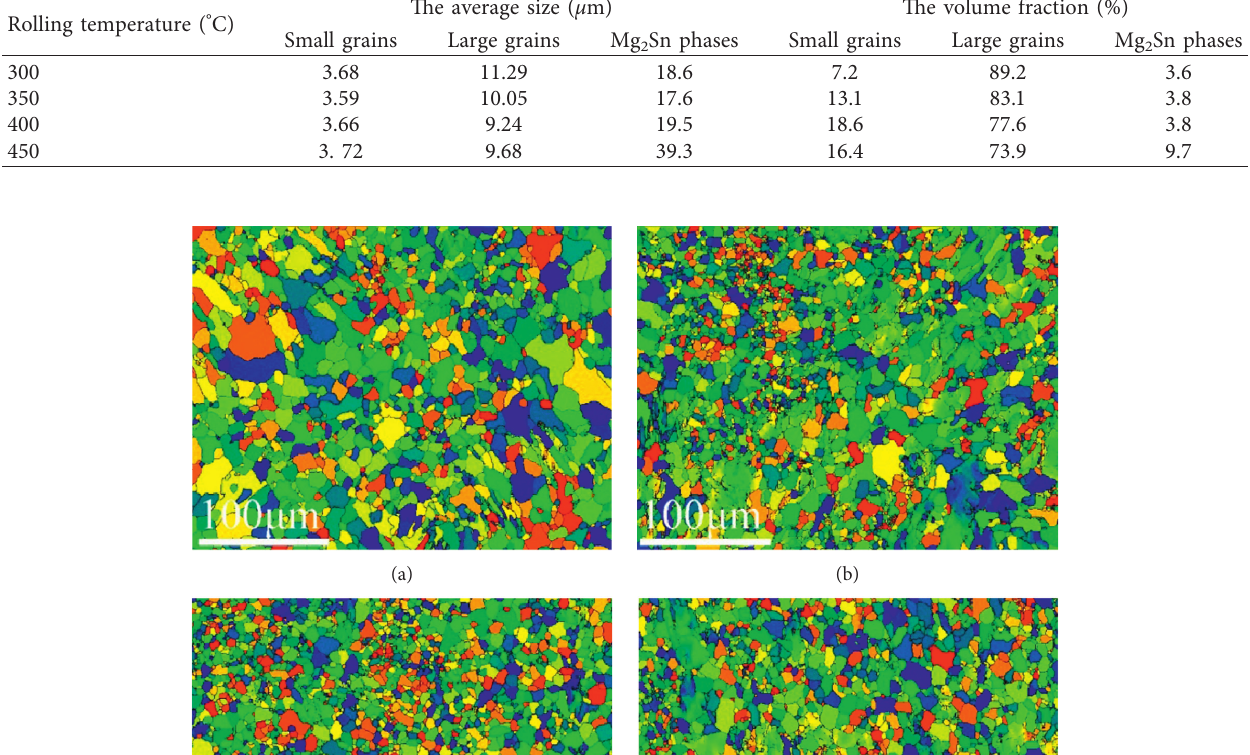
Table 1: The average sizes and volume fractions of Mg Rolling temperature ( ° C)